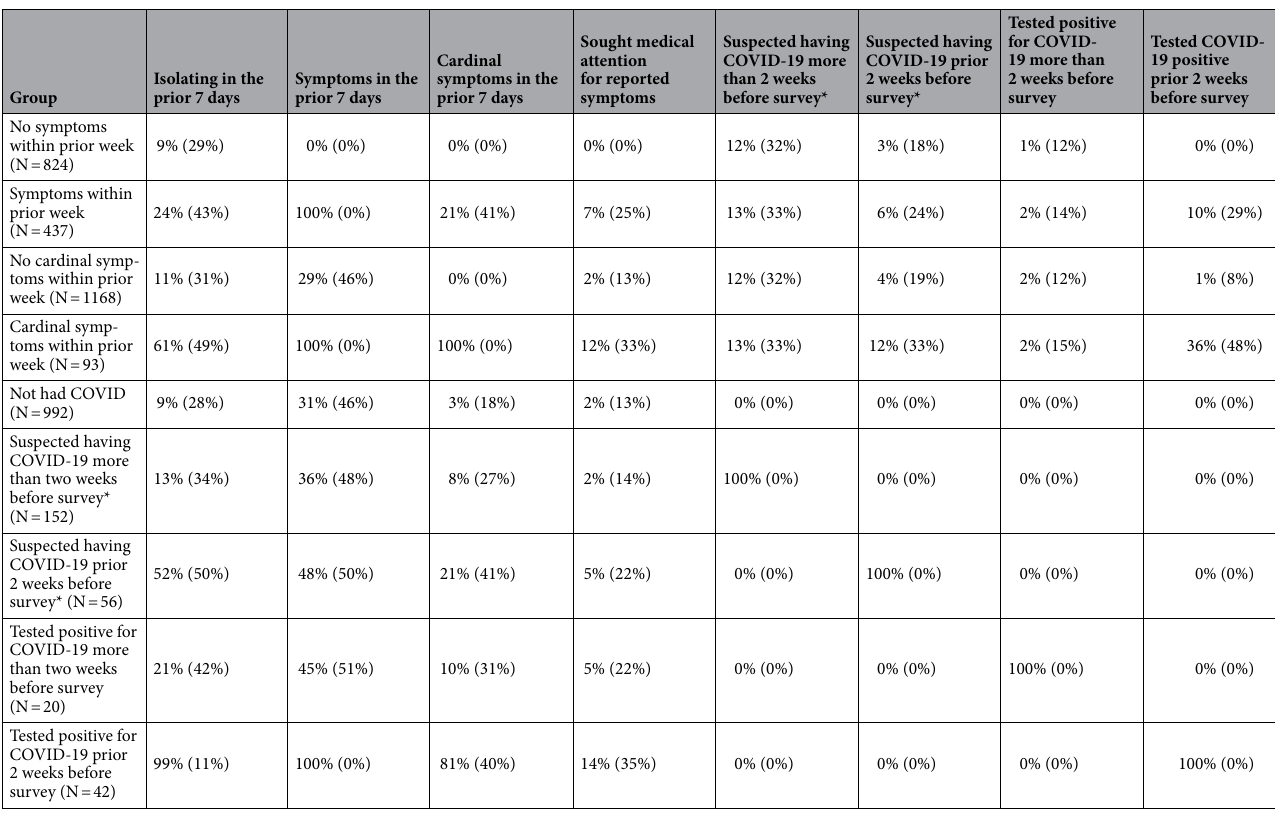
Table 4. Percentage (and standard deviation) of students reporting behaviours or COVID-19 characteristics (weighted), stratified by other behaviours and characteristics. *Medical professional’s opinion or personal